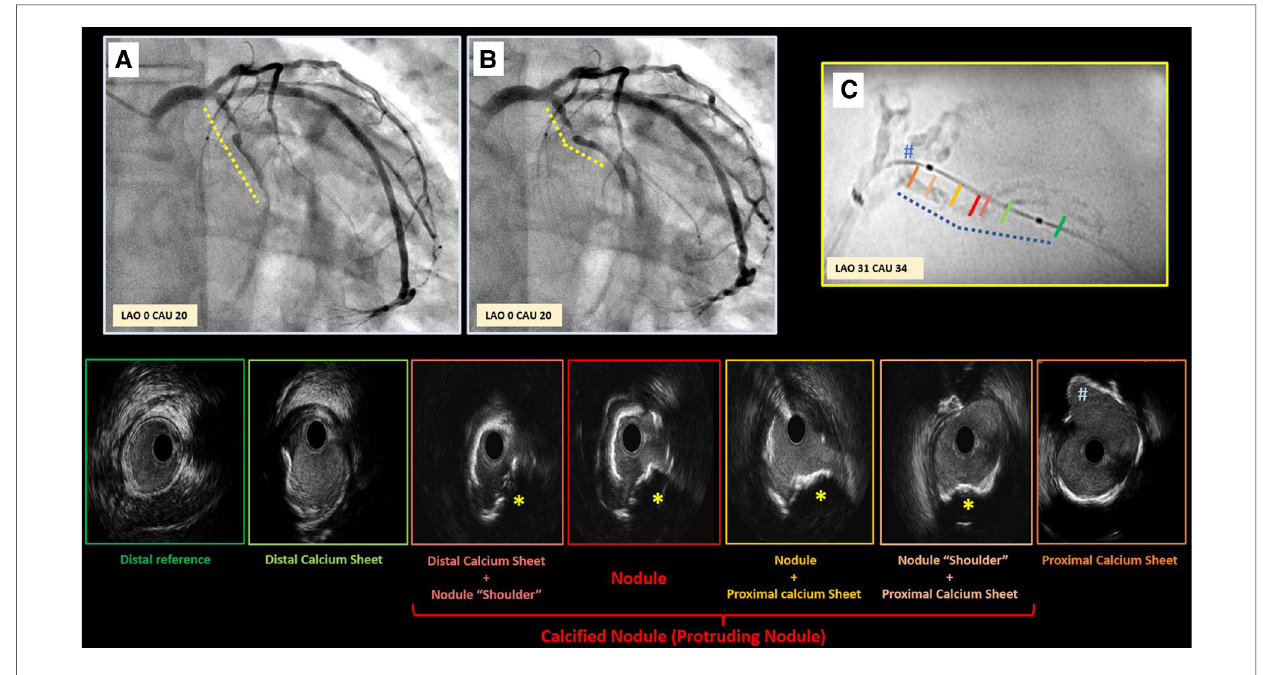
FIGURE 5 Case example supporting pathogenesis of calci fi ed nodule. Panel A,B depict critical stenosis in left circum fl ex, with dotted lines highlighting the high motion and excursion of the mid part of the vessel compared to proximal segment during the cardiac cycle (Panel A exhibits diastole; B exhibits systole) with a hinge point right at the site of focal critical stenosis. Enhanced angiography clearly depicts the signi fi cant amount of calcium (Panel C ). Intravascular ultrasound was performed revealing the presence of a non-concentric sheet of calcium distally that become more concentric as it gets closer to the focal stenosis (red panel) where a protruding nodule is clearly detectable (yellow star). This calci fi ed sheet continues proximally into a non-concentric sheet of thick calcium as approaching the ostium of the fi rst marginal branch